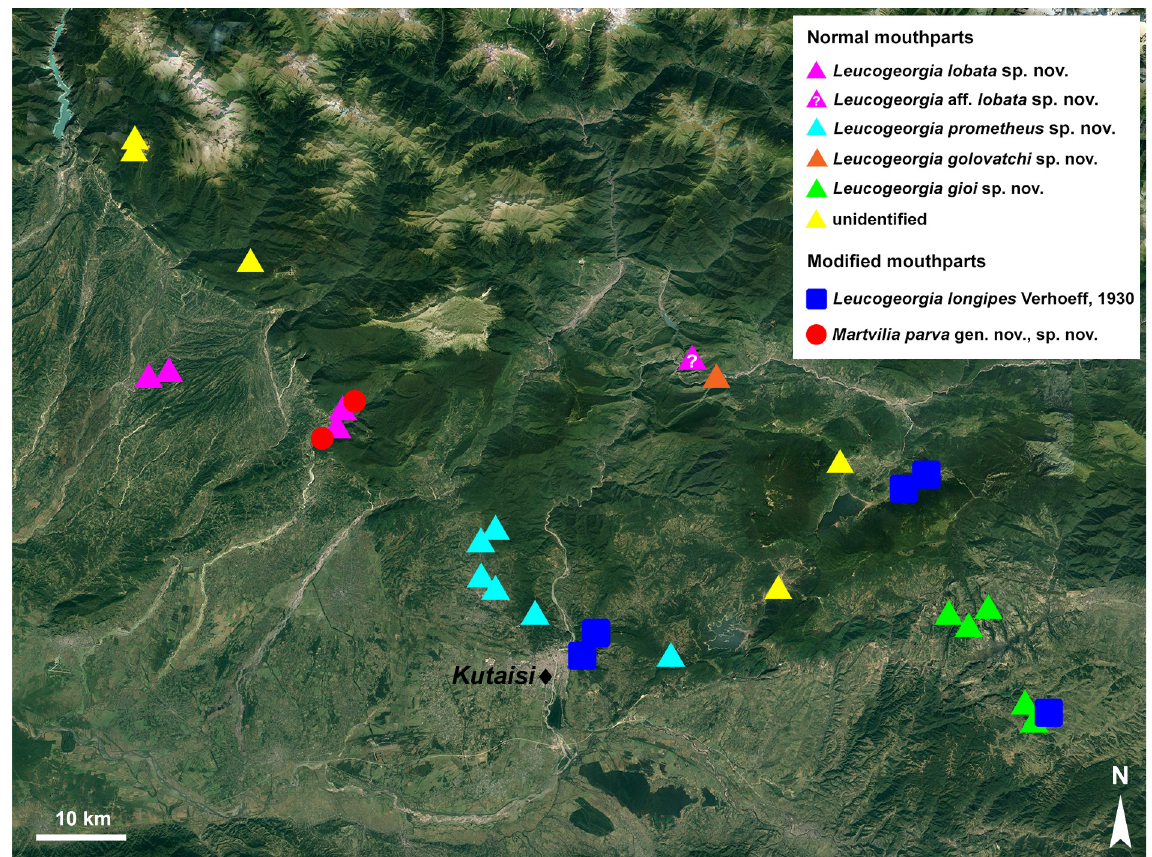
Fig. 58. Distribution of the southeastern group of the genus Leucogeorgia Verhoeff, 1930 and the species Martvilia parva gen. et sp.